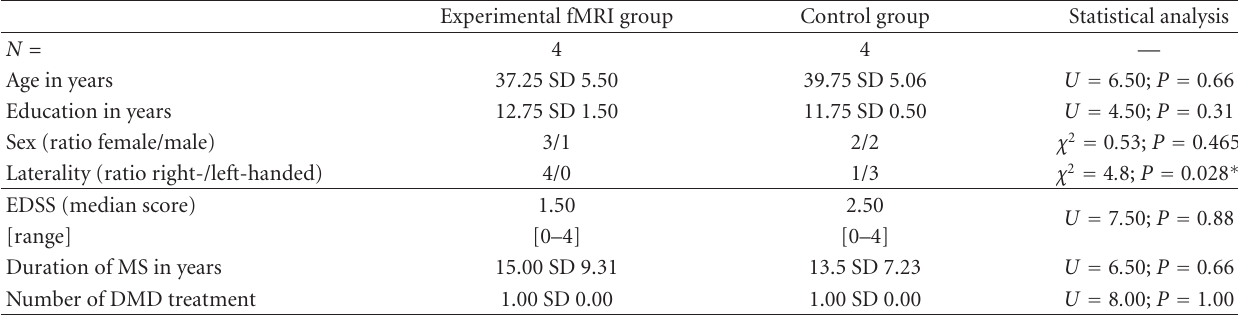
Table 1: Demographical and clinical data (mean and standard deviation) for the two groups of MS